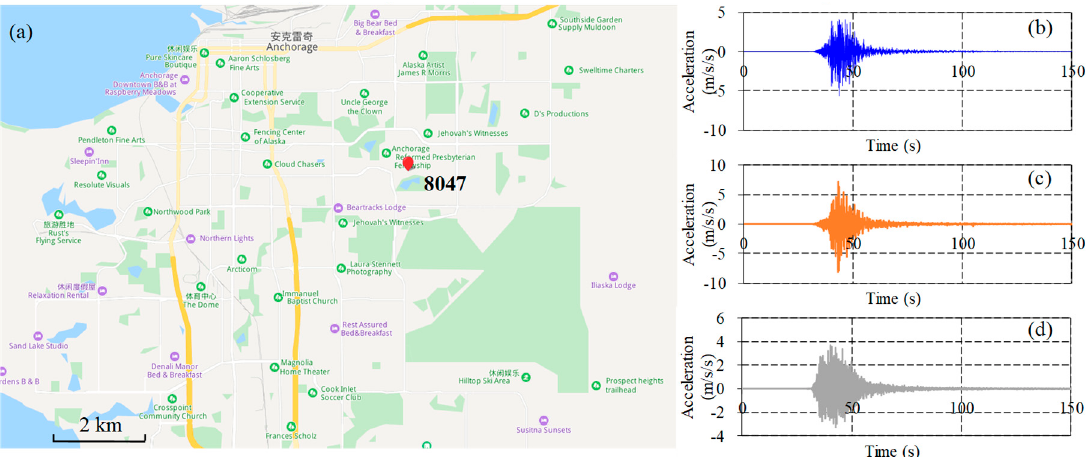
Figure 11. ( a ) Location of the 8047-ground motion station, and the ground motion recorded by the 8047 station: ( b ) EW direction, ( c ) NS direction, ( d ) UD direction.